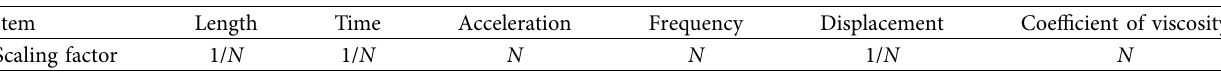
Figure 1: IWHR centrifuge shaking table and the layout of container and cameras. Table 2: Scaling factors (model/prototype) used in the centrifuge shaking table tests carried out at Ng .